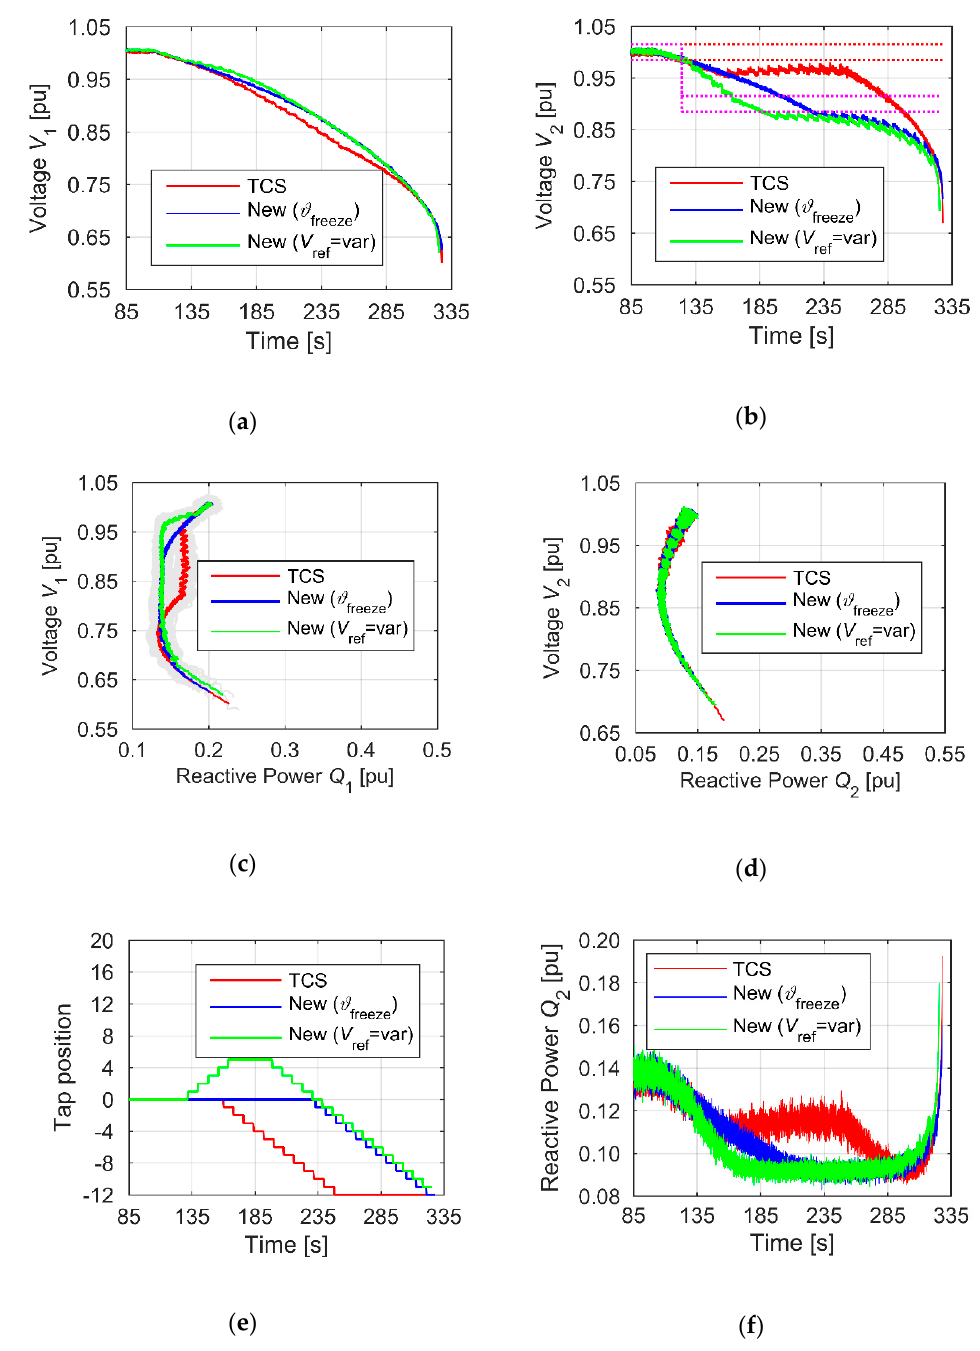
Figure 16. Verification of the effectiveness of the proposed algorithm, tests on the physical model—variant B: ( a ) voltage V 1 ; ( b ) voltage V 2 ; ( c ) characteristics V 1 = f( Q 1 ); ( d ) characteristics V 2 = f( Q 2 ); ( e ) tap position; ( f ) reactive power Q 2 .